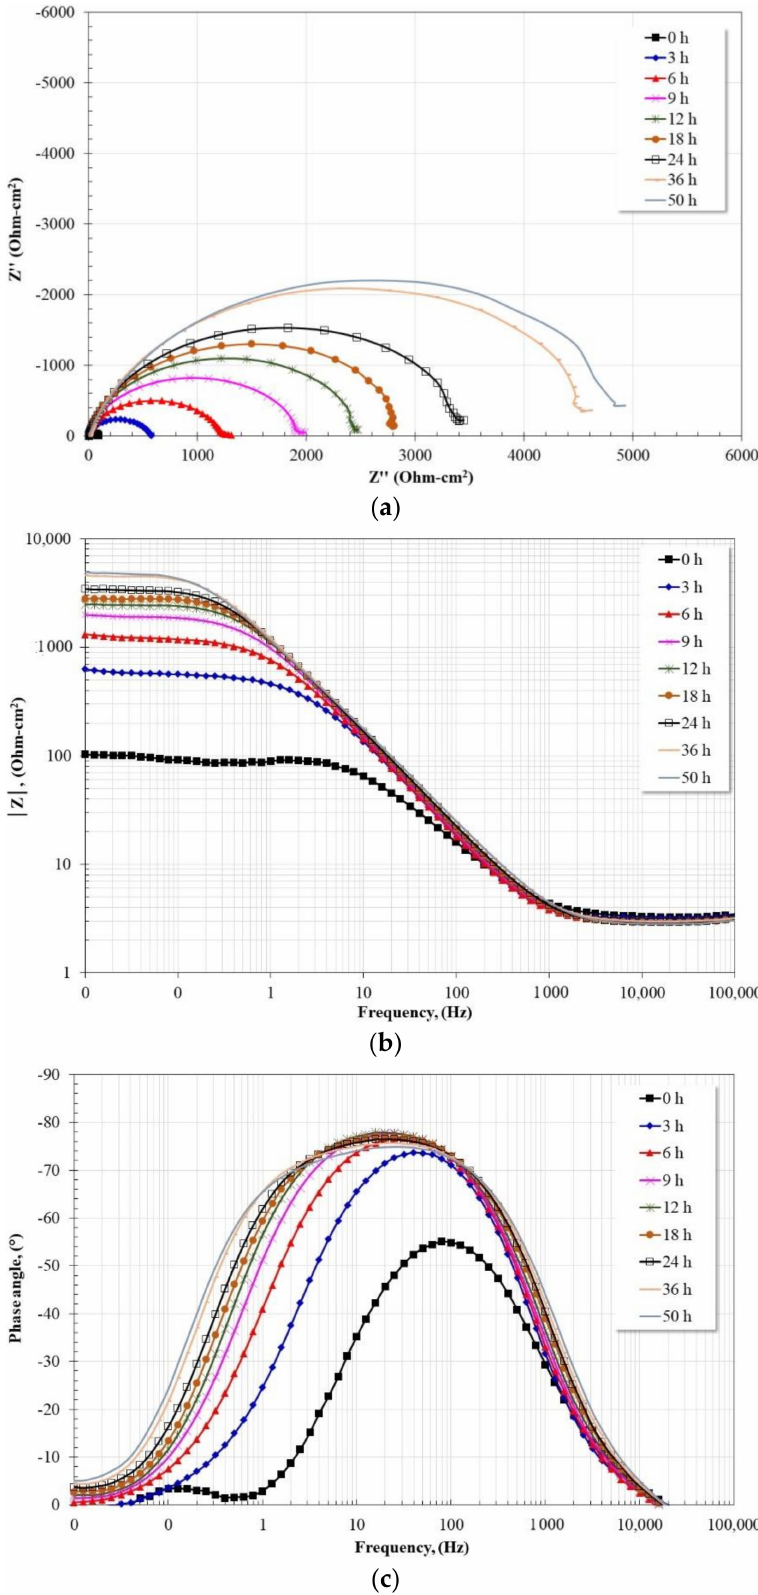
Figure 7. Evolution of Nyquist and Bode diagrams for 1018 carbon steel in CO 2 -saturated brine at 60 ◦ C and 1 mM of LaCl 3 . ( a ) Nyquist diagram; ( b ) Bode diagram in its impedance modulus format; ( c ) Bode diagram in its phase angle